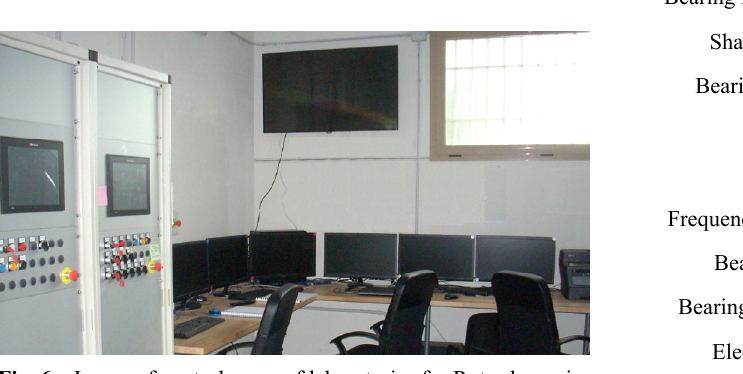
Fig. 6 Image of control room of laboratories for Rotordynamics and Bearings and for Mechanical Transmissions.